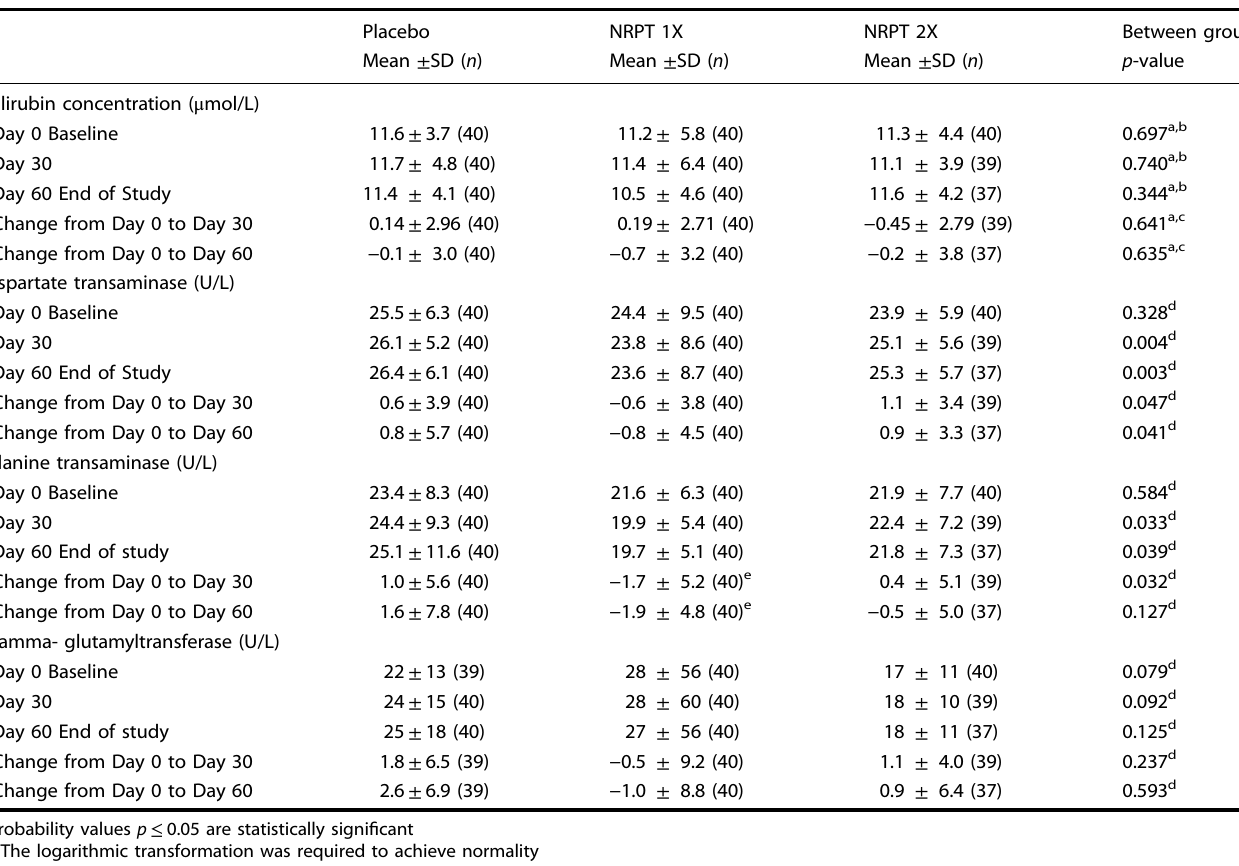
Table 2. Liver function tests of all participants ( N = 120)